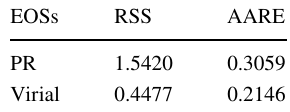
Table 7 Statistical errors of PR and Virial EOSs in comparison with SRK EOS